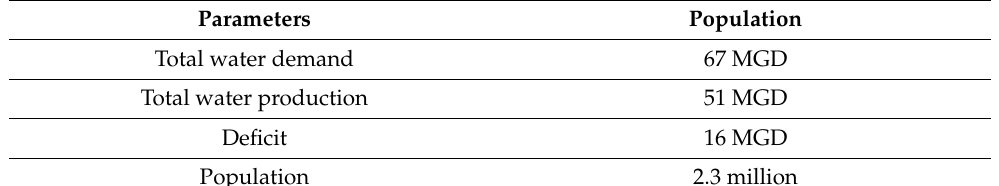
Table 2. Overview of water demand, usage, and accessibility in the study area.